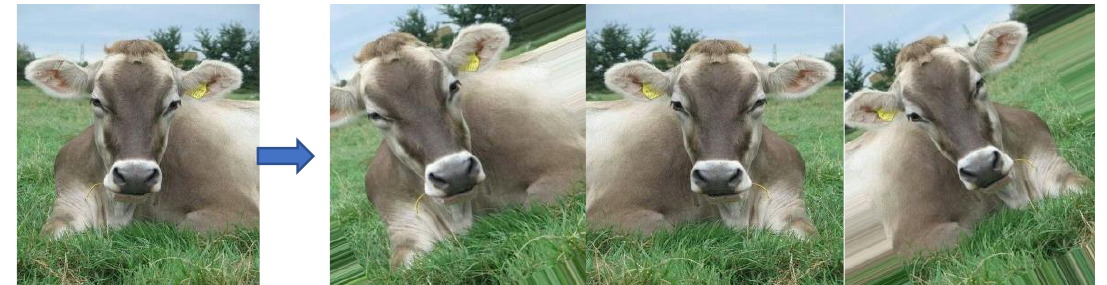
Figure 8. Sample augmented images.